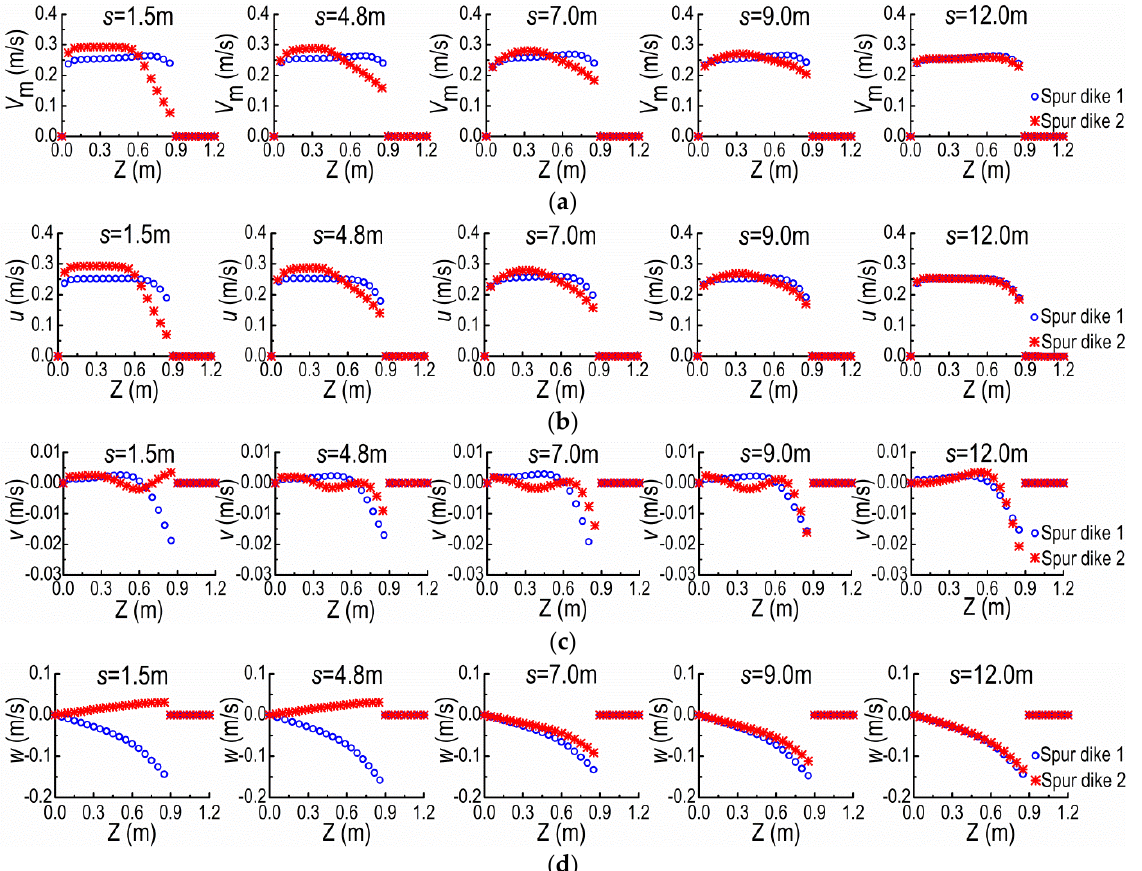
Figure 13. Velocity distributions along Z-direction at SD1 and SD2 under different s values . ( a ) V m curves. ( b ) u curves. ( c ) v curves. ( d ) w curves.